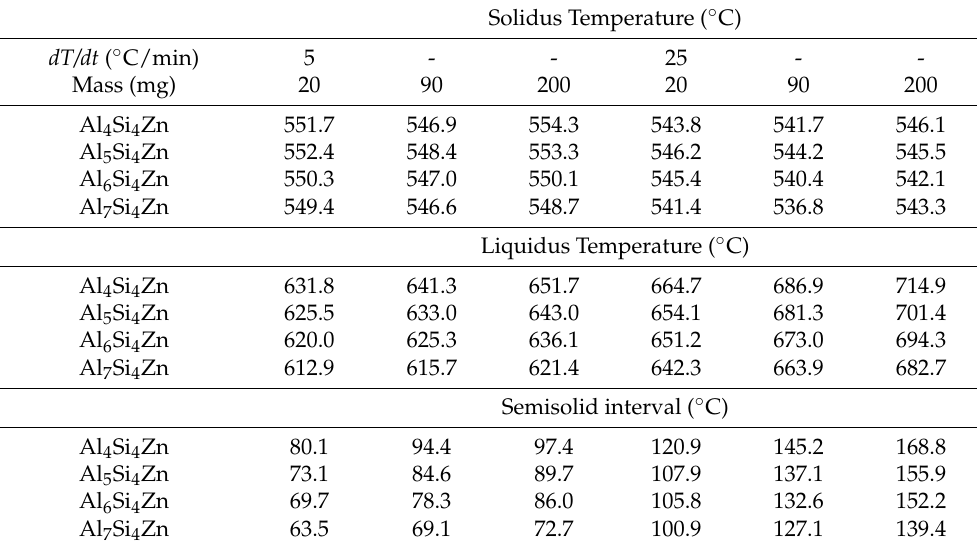
Table 4. Solidus, liquidus and semisolid interval for the melting transformation for the alloys studied here when heated at 5 and 25 ◦ C/min with different sample masses.